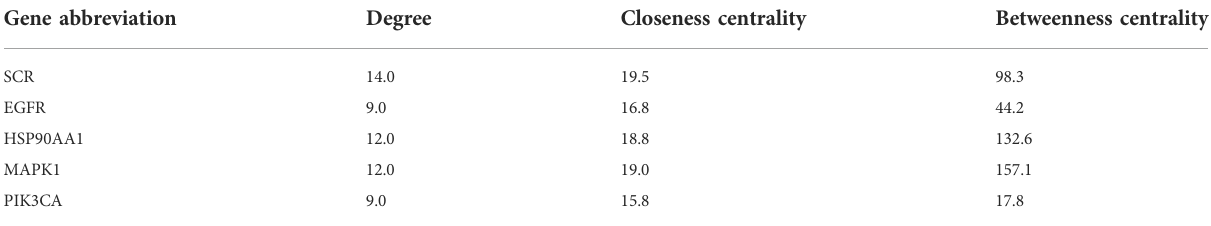
TABLE 2 Top fi ve targets with potentially critical roles in SchB treatment of adenovirus_hepatitis. Gene